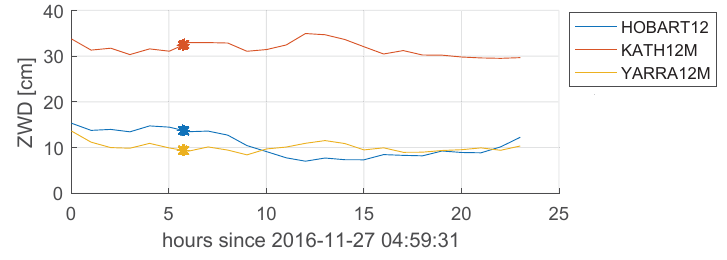
Figure 11. Zenith Wet Delay (ZWD) estimated from quasar observations in Experiment a332. The time at which the APOD Scans 168 and 169 were observed are